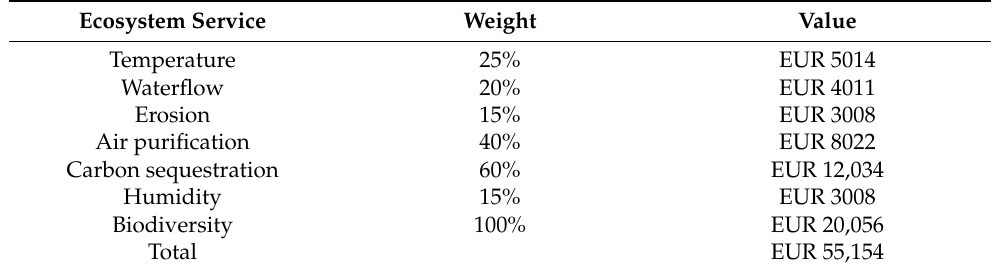
Table 4. The new total value of the considered scenarios per ha according to EU ETS Phase 4. Non- Non- Provisioning Provisioning Provisioning Total Value Scenarios Ecosystem Ecosystem Ecosystem Services NPV Services Value Services Range Landscape EUR 5486 0.93 EUR 51,293 EUR 45,807 Fibre EUR 2386 0.60 EUR 35,478 Food EUR 3323 0.57 EUR 31,438 EUR